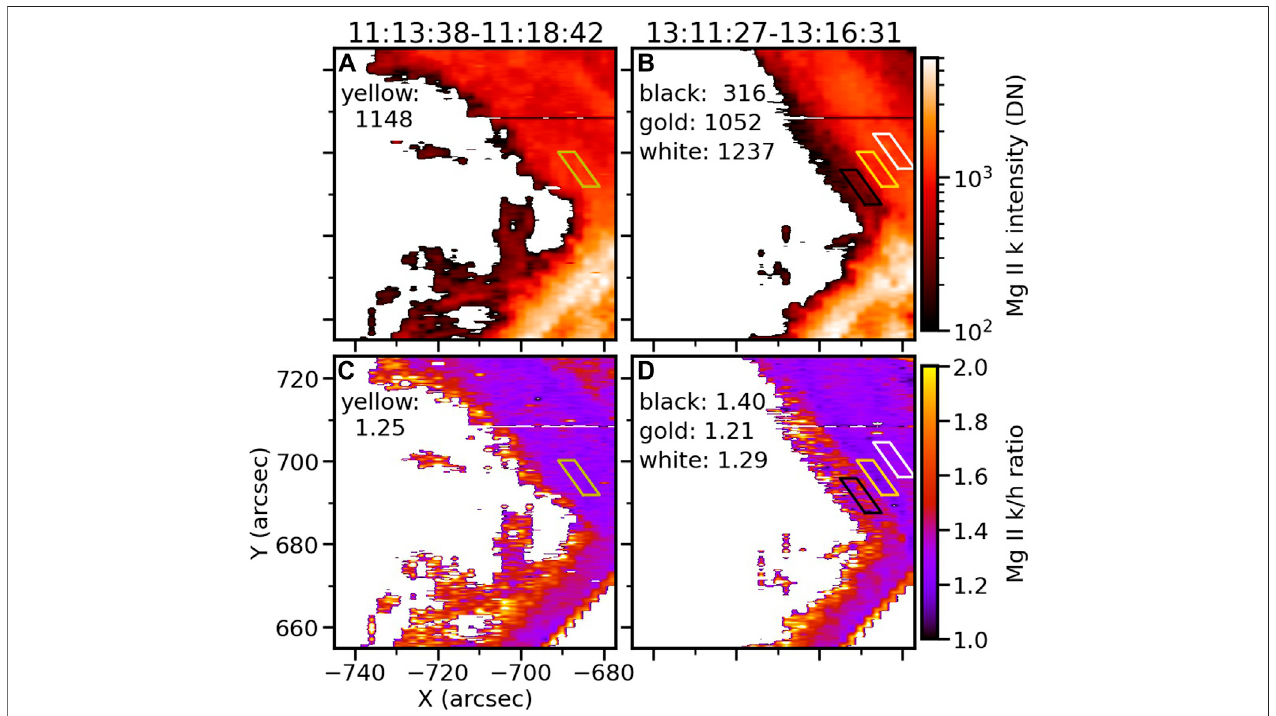
TABLE 2 | Main observational results of this work. Prominence eruption (1) Slow-rise phase Evolution of spectra